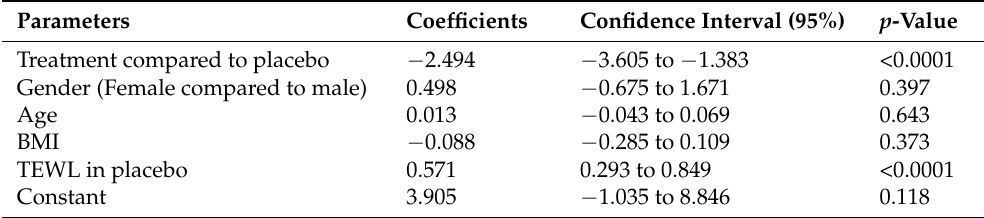
Table 4. Linear regression analysis of changes in the transepidermal water loss (TEWL) after 4 h of